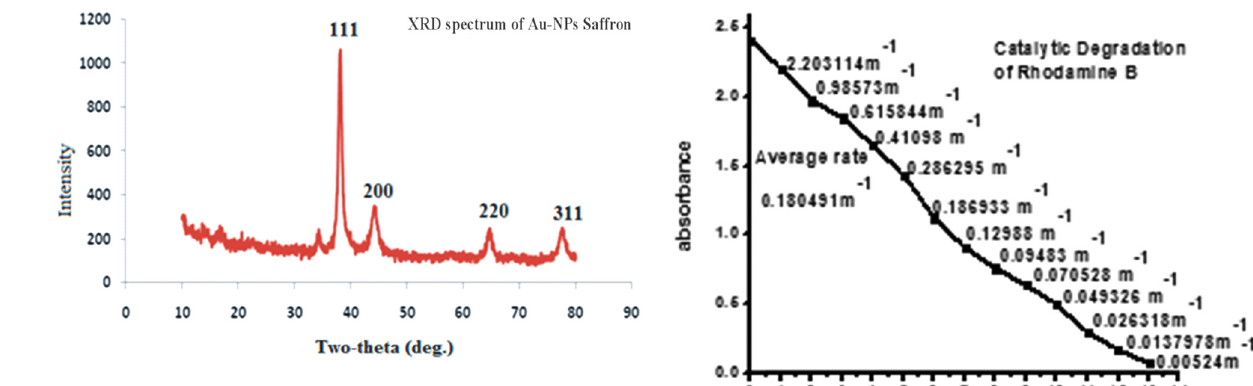
Figure 15: XRD spectra of AuNPs of sa ff ron ( SS - AuNPs ) .